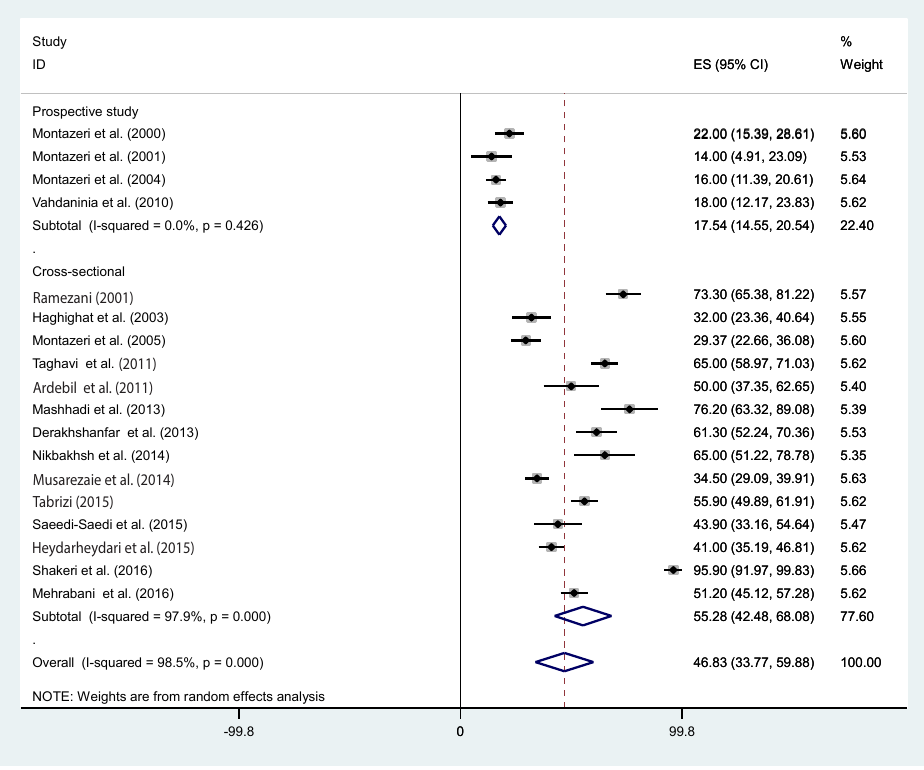
Figure 6. Forest plot of all studies based on study design. ES, effect size (prevalence); CI, confidence